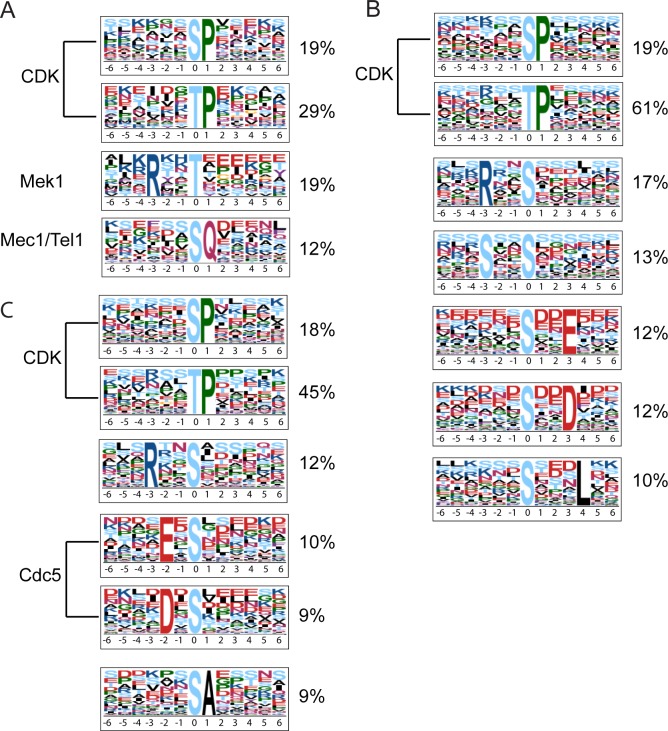
Consensus phosphorylation sites determined by Motif-X analysis of dmc1Δ mek1-as SILAC phosphopeptides.(A) Motif-X analysis of the 329 Class I peptides with L/H ratios ≥ 2. (B) Motif-X analysis of the 5317 Class 2 peptides with L/H ratios between 0.5–2.0. (C) Motif-X analysis of the 963 Class 3 peptides with L/H ratios < 0.5. Percentages represent the fraction of peptides containing either phosphothreonine or phosphoserine. The size of each amino acid shows how enriched it is relative to the phosphorylated amino acid, and the color indicates physical and chemical properties of the indicated amino acid (Red: acidic; Dark blue: basic; Black: hydrophobic; Yellow: cysteine; Green: proline/Glycine). The percentages of phosphopeptides containing the motifs are indicated. All of the motifs exhibited significant enrichment with a p-value of 0.01.